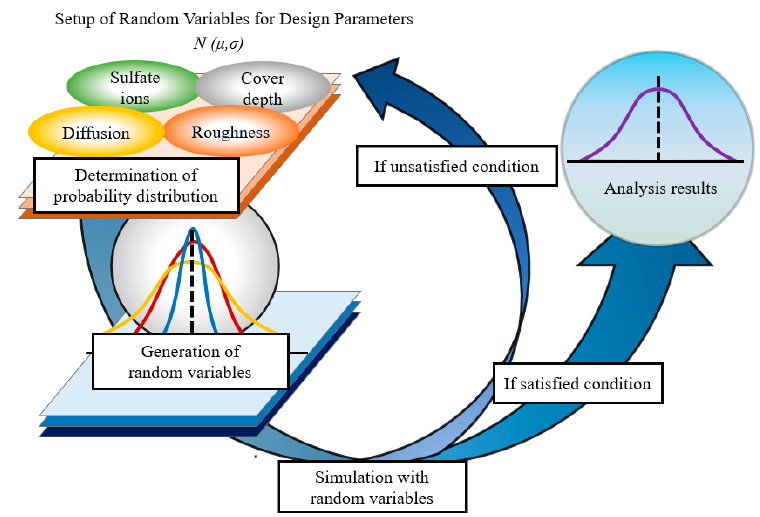
Figure 4. Analysis step of MCS with random variables of design parameters.